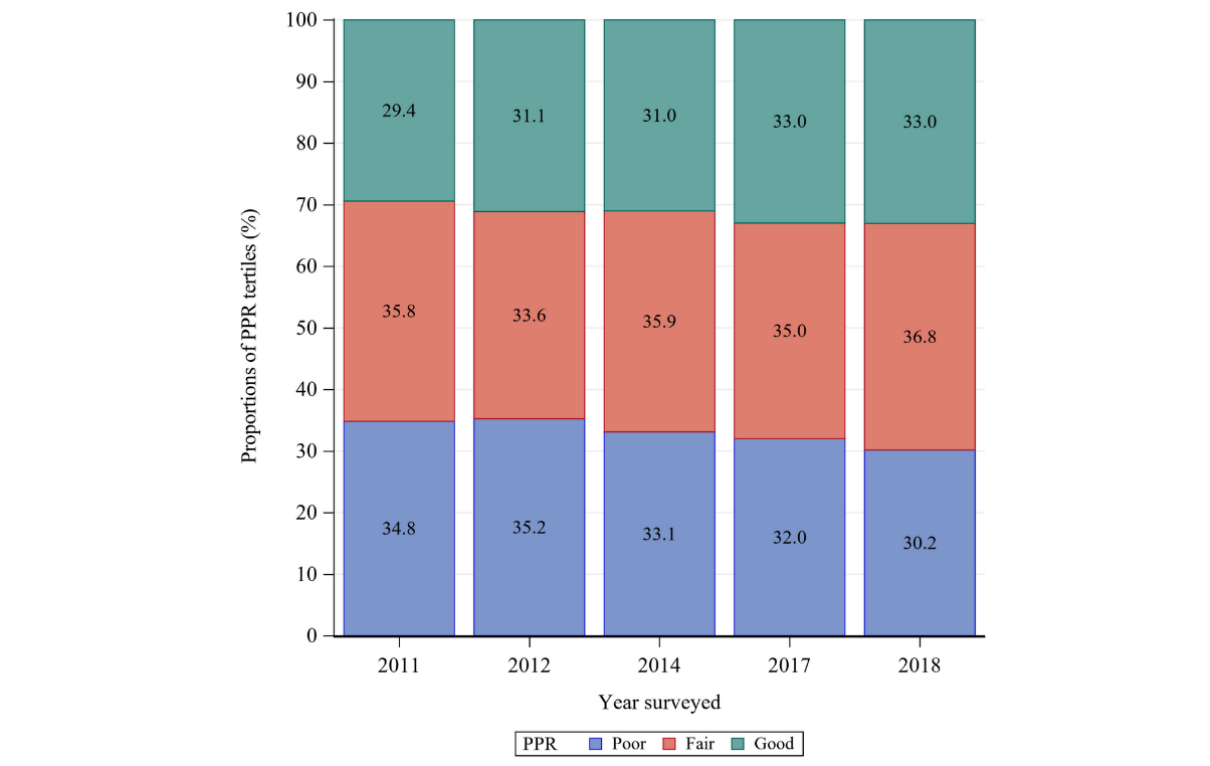
Figure 3. Unadjusted proportions of patient-physician relationship tertiles based on the Health Information National Trends Survey between 2011 and 2018. PPR: patient-physician